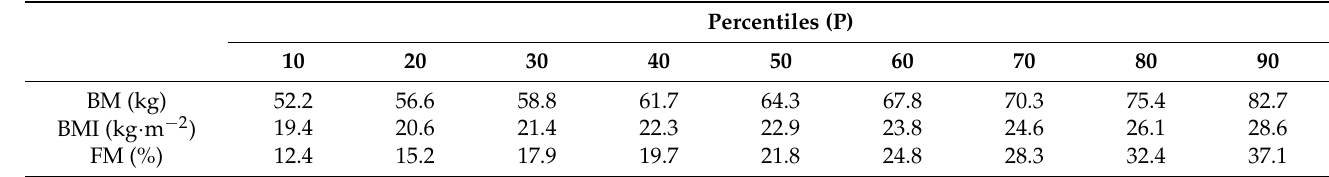
BM = body mass; BMI = body mass index; FM = Fat Mass.